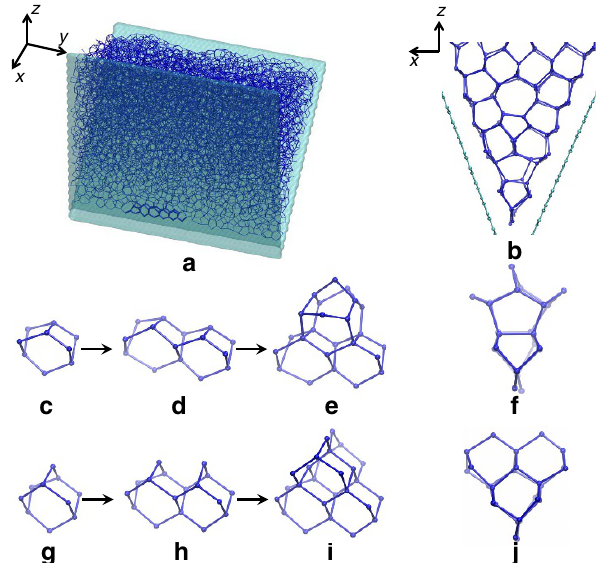
Figure 3 | Molecular pathways of mW ice crystallizing near the tip of special wedges. ( a ) Supercooled water (blue) at 230K within the 45 (cid:2) wedge (green). The spontaneous formation of an ordered structure (highlighted) near the wedge contact line eventually leads to ice crystallization. Side view of ice is shown in b . ( c – e ) Nucleation pathway of ice within the 45 (cid:2) wedge. As a comparison, the nucleation pathway within the 70 (cid:2) wedge is shown in g – i . ( f , j ) Side views of the defect complex ( e ) and cubic ice complex ( i ),